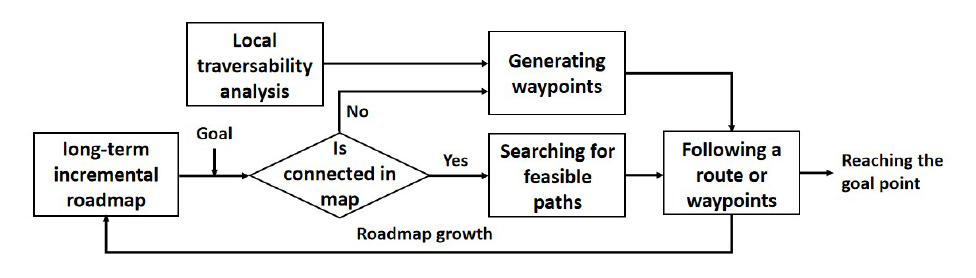
Figure 9. Global planning flowchart.